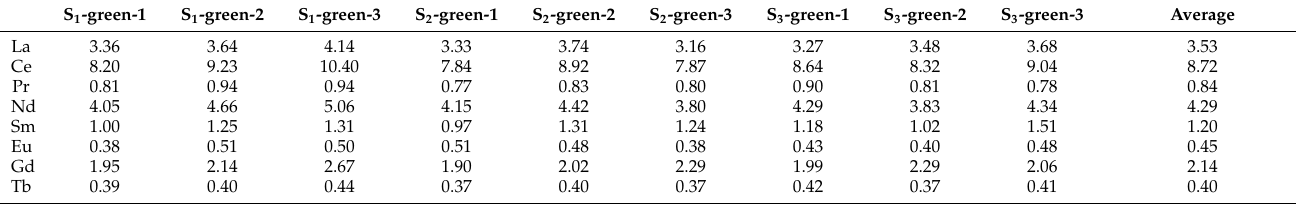
Table 4. REE characteristics of three Lvwen stone specimens (all values in